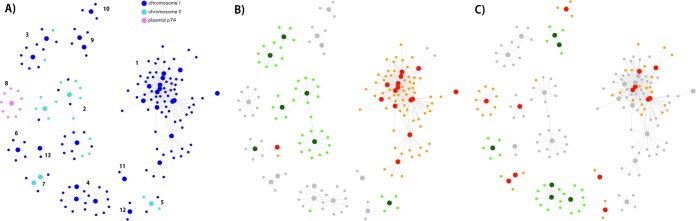
Coexpression networks. The figure shows the 13 coexpression networks that resulted from analyzing positively correlated genes. The big circles represent genes involved in regulatory processes and in panels B and C are colored red if they are upregulated and dark green if they are downregulated. Small circles are colored orange for upregulated genes and light green for downregulated genes. Gray circles are genes without differential expression under that condition. (A) Genes are colored by replicon. (B) Differentially expressed genes at 48 h. (C) Differentially expressed genes at 120 h.